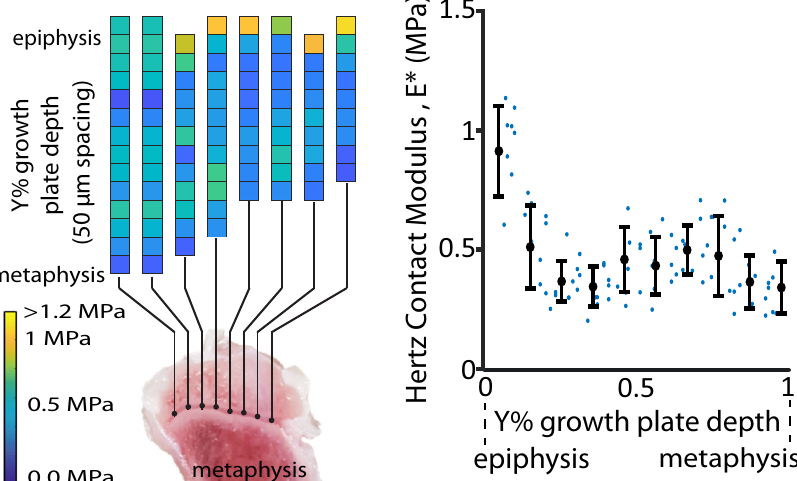
Fig. 2 Mechanical characterization of a New Zealand white rabbit growth plate tissue. Modulus results were obtained from micro-indents in arrays spanning the growth plate cartilage at eight different locations (left). Hertz contact moduli were averaged anterior – posterior and evaluated as a function of depth across the growth plate (i.e., Y% with respect to the epiphyseal and metaphyseal junction) with a bin size of 10%. Small blue dots represent individual data points, bold black dots represent mean ± standard deviation (error